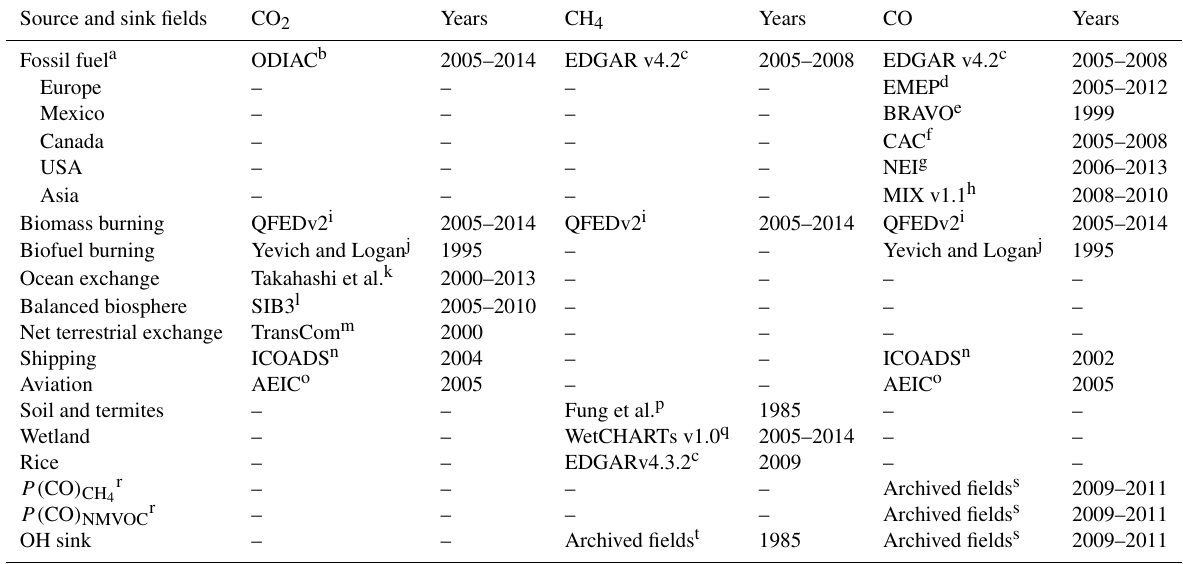
Table 1. GEOS-Chem emission inventories and chemical fields used for the three carbon gas simulations. Years represent periods when time-specific inventories were available during our simulation time period (2005–2014).